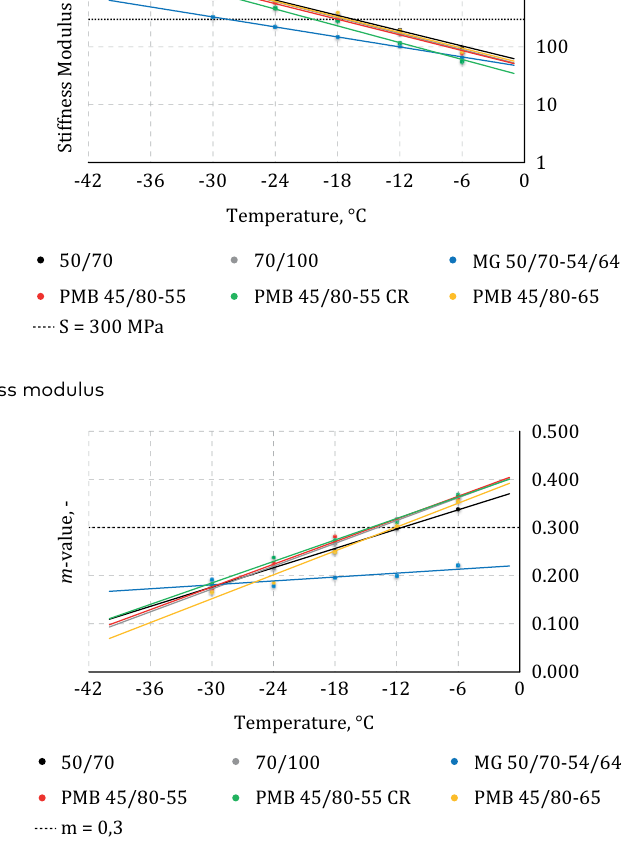
Figure 7. Stiffness modulus and m -value parameter at 60 seconds loading from the Bending Beam Rheometer test versus temperature for soft consistency